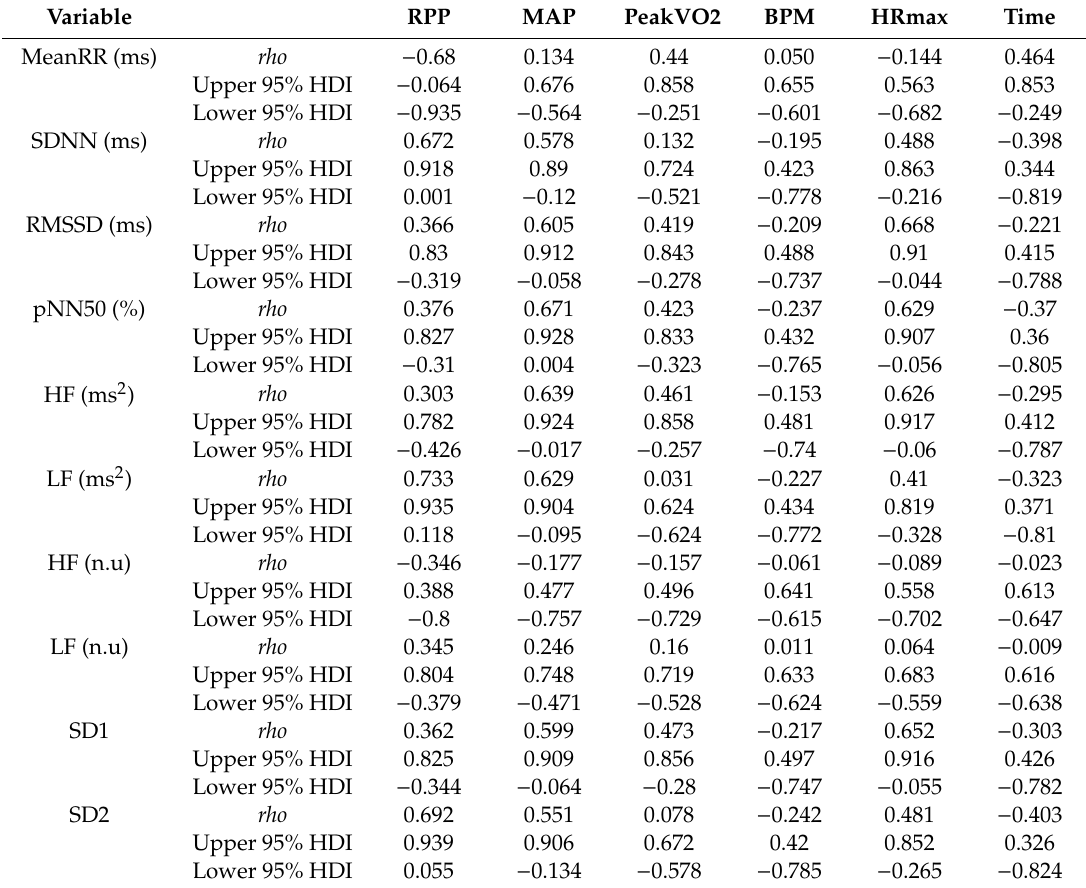
Table 6. Correlation matrix between HRV measures from time domain, frequency domain and nonlinear